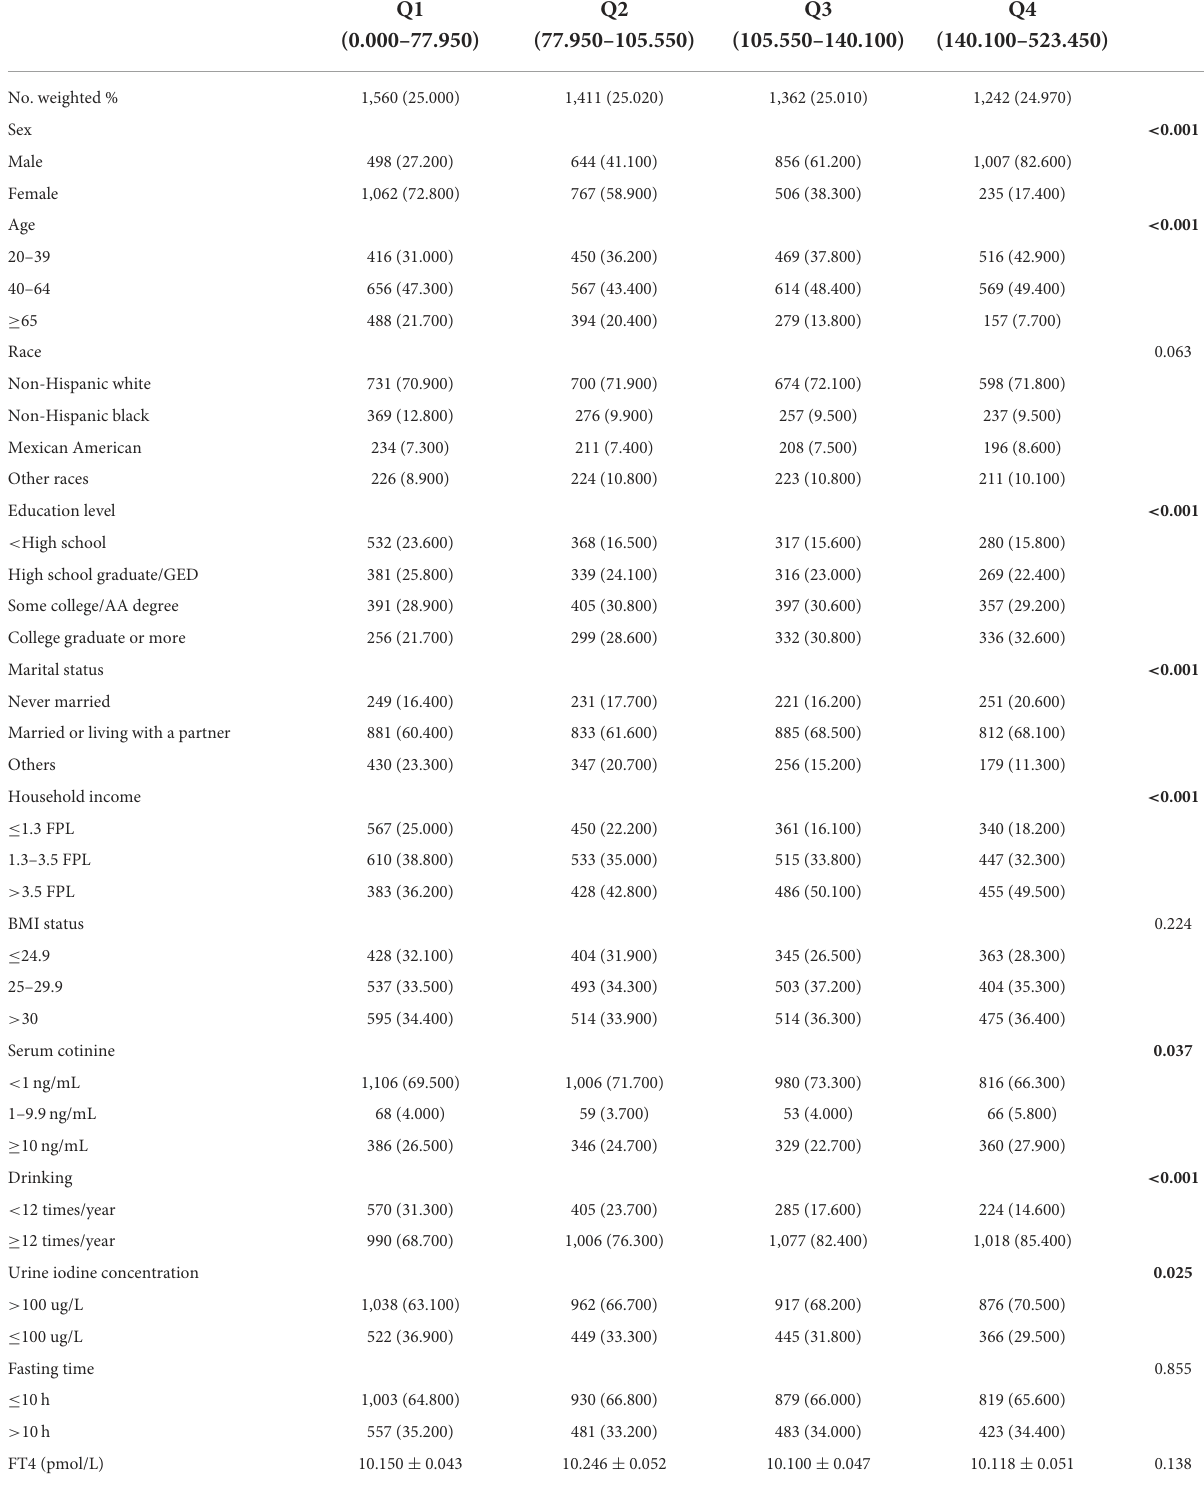
TABLE 1 Characteristics of study